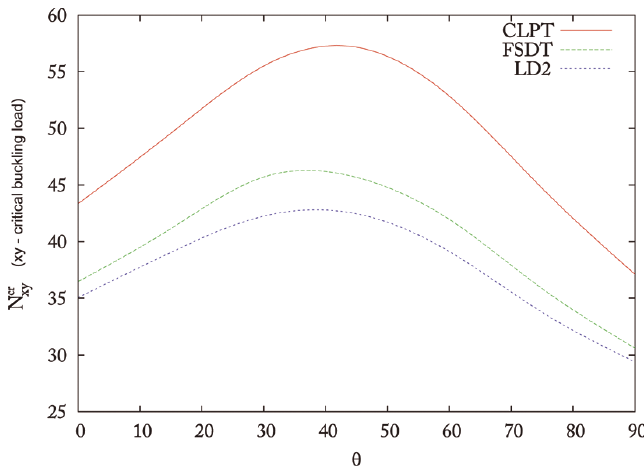
Fig. 6. N xy PLATE-33, Q4, 10 × 10, a h = 30, a = b,